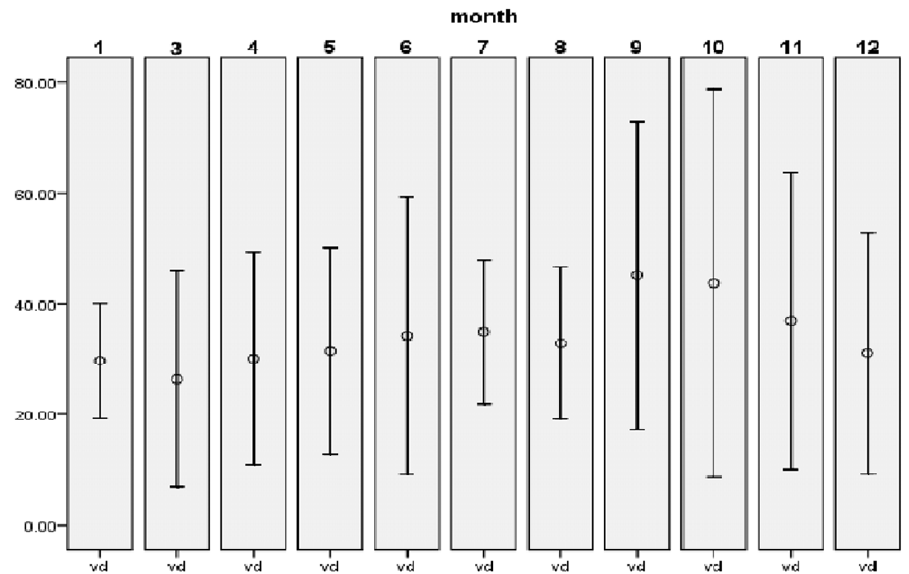
Figure 1. Mean 25(OH)D value of each month through the year (except Feb). The lowest was in March, 26.1 6 9.7 nmol/L, highest was in September and October, 45.1 6 14.0 nmol/L-44.1 6 15.2 nmol/L.